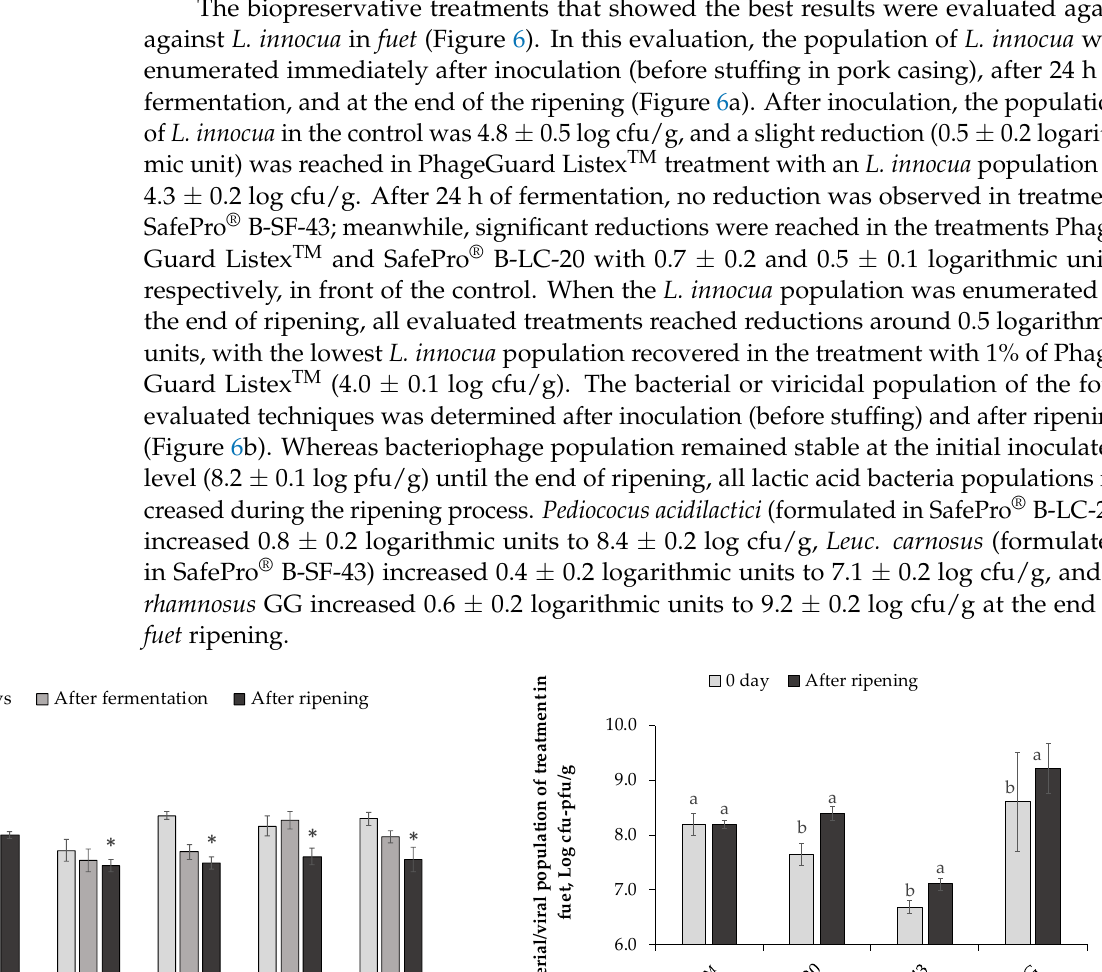
Table 2. Effect of the biopreservation application on pH of fuet . Values are means ± standard devi- ations of three biological replicates. Different letters in the same column show significant differences among treatments ( p < 0.05) at each sampling time.